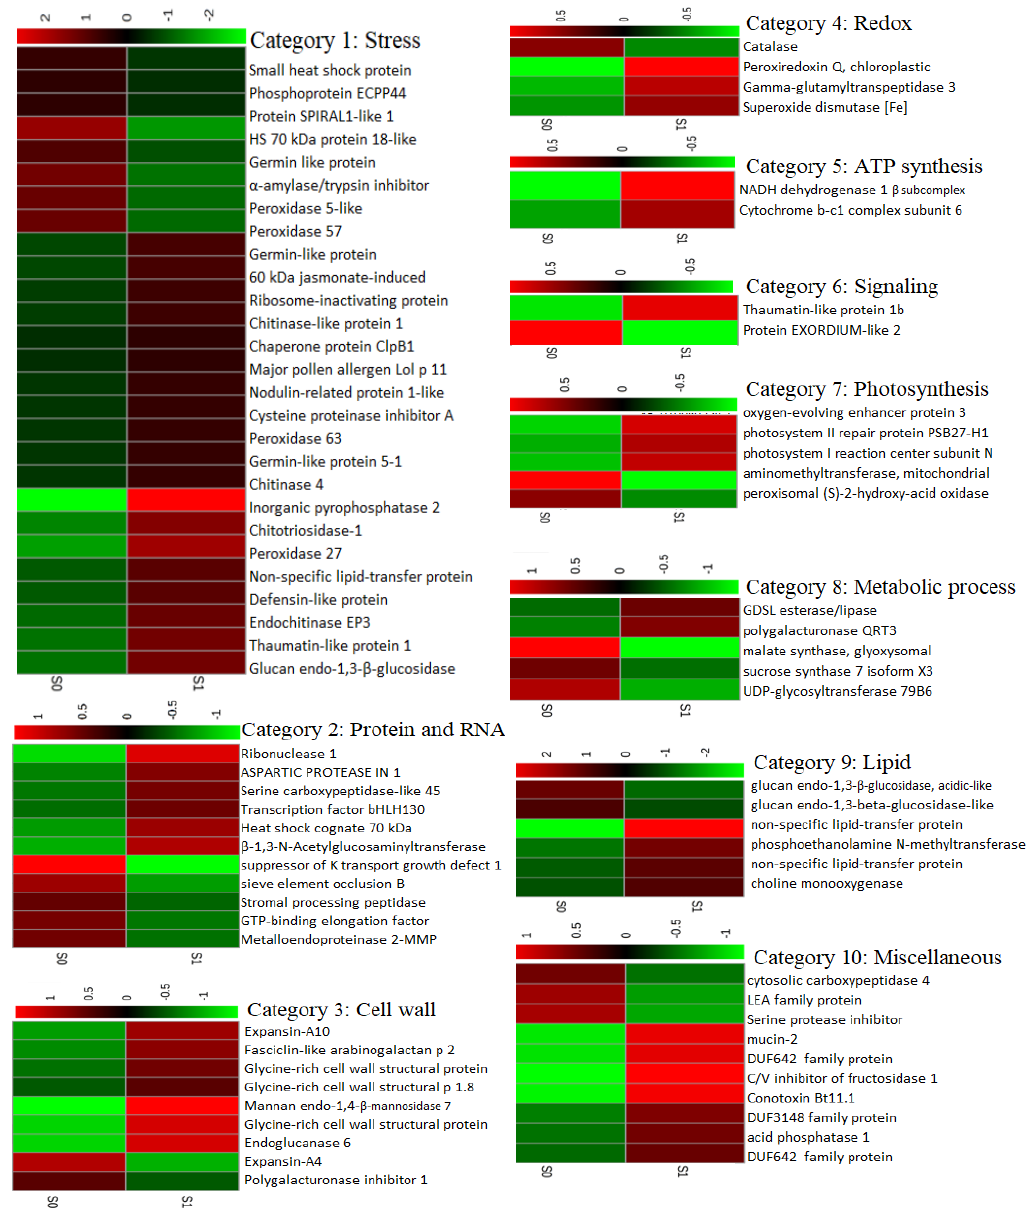
Figure 8. Heat maps (based on Z-scores of the protein abundance measurements) demonstrating abundance patterns of individual proteins within each functional category in sugar beet GCs. The colour intensities shown correspond to the Z-scored LFQ intensities, according to the key shown at the top of each heat map. S0 and S1 denote control and saline treatments,